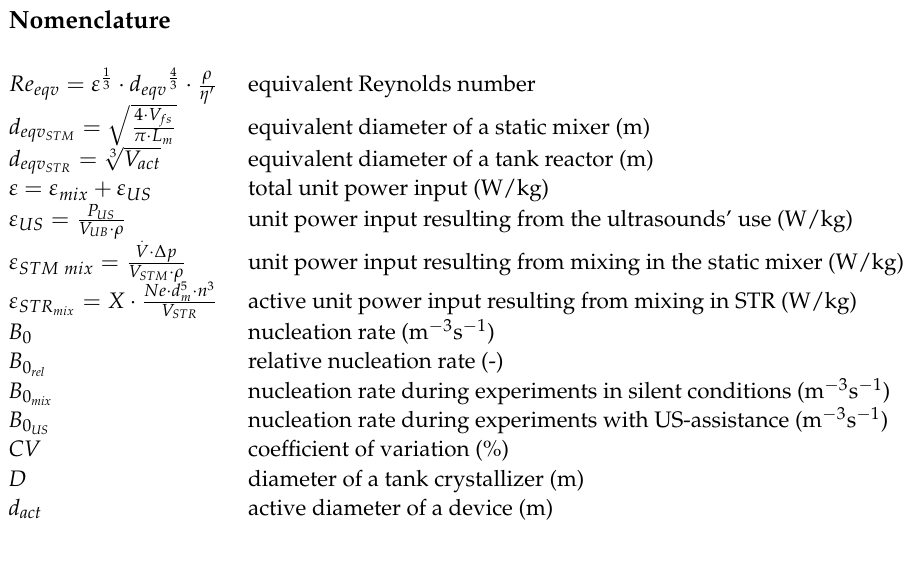
The influence of US power on particle density distribution q 3 for both examined reactor types; Table S1: Properties of the reactants; Table S2: Dimensions of the used reactors; Table S3: Operating conditions of the precipitation process carried out in the Koflo STM for the constant value of ε mix = 0.1 W/kg; Table S4: Operating conditions of the precipitation process carried out in the Koflo STM for the constant value of ε US = 14.9 W/kg; Table S5: Operating conditions of the precipitation process carried out in the STR for the constant value of ε mix = 0.4 W/kg; Table S6: Operating conditions of the precipitation process carried out in the STR for the constant value of ε US = 14.9